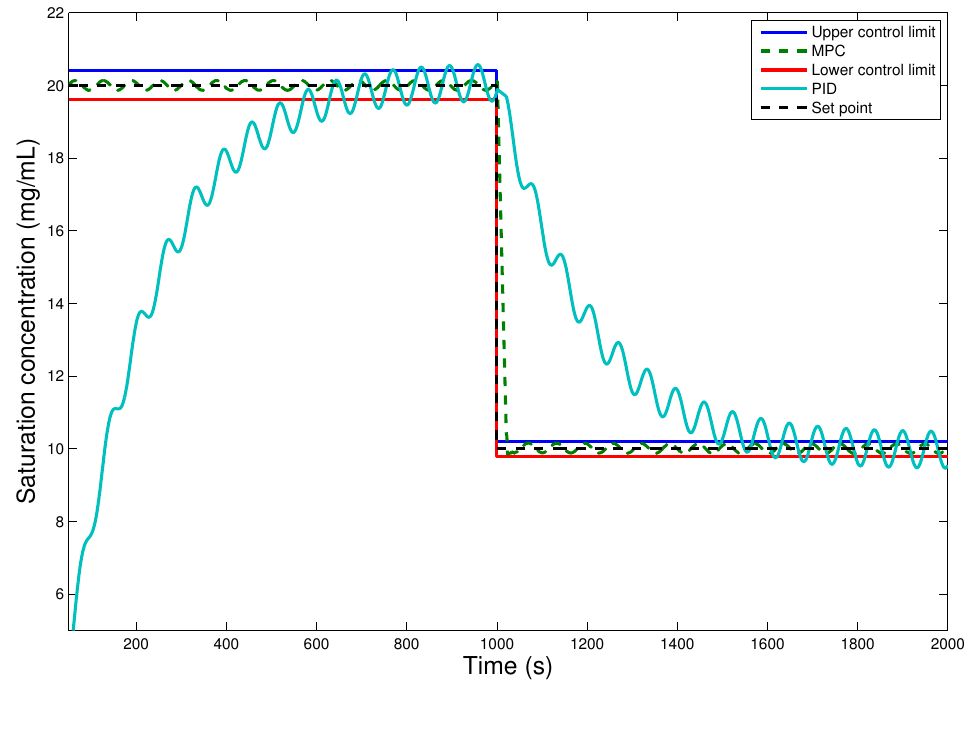
Figure 7. Disturbance rejection ability of controllers for the saturation